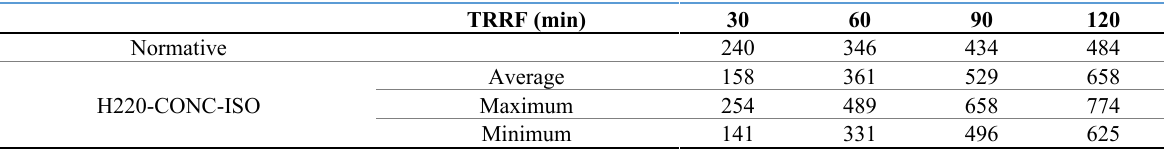
Table 7. Comparison of the temperatures obtained in the numerical model with the normative values for the concrete between the flanges of the columns with heating on all sides.